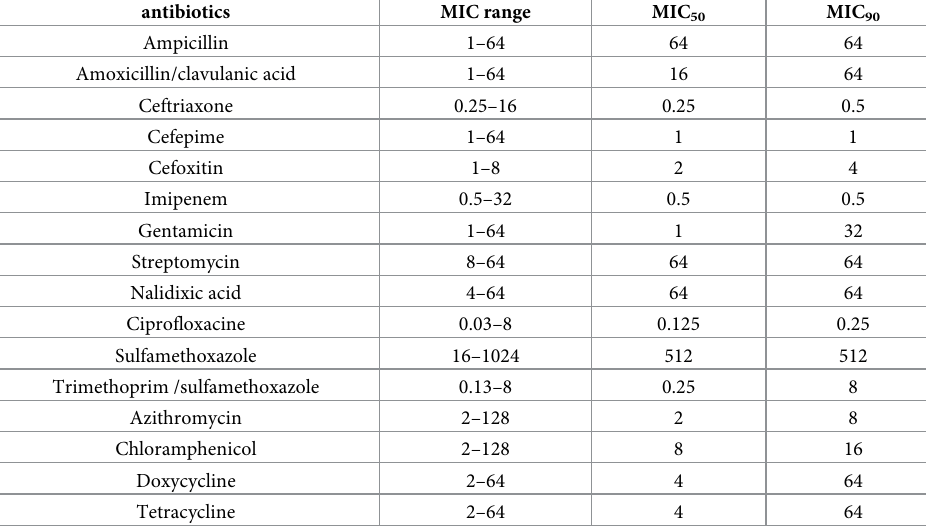
Table 2. MIC 50 and MIC 90 of 16 antibiotics for 79 S . Enteritidis clinical